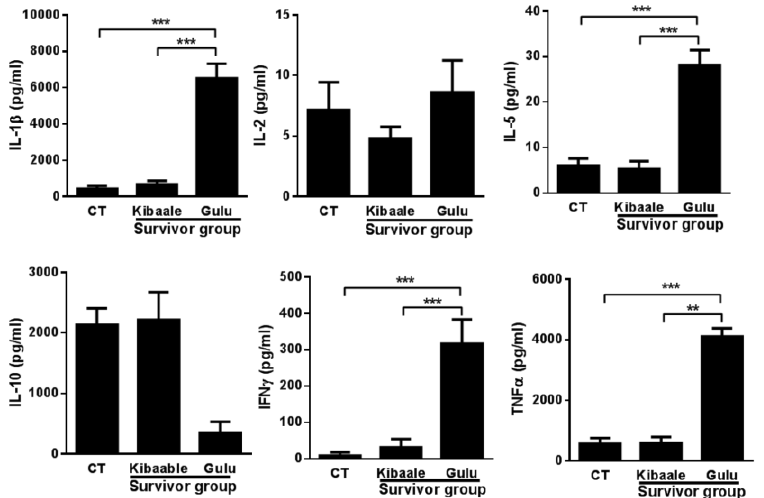
Figure 3. Cytokine levels comparison between EBOV GP 1–649 stimulation and unstimulated whole blood from Kibaale (1-year) and Gulu (12-year) ebolavirus survivors and non-infected controls (CT). Cytokine levels were measured in the plasma supernatants of samples following whole blood stimulation. Non-infected controls of Kibaale and Gulu are presented as average results since there were no significant changes between the two groups of controls (Data not shown). Mean ± SEM, * p < 0.05.